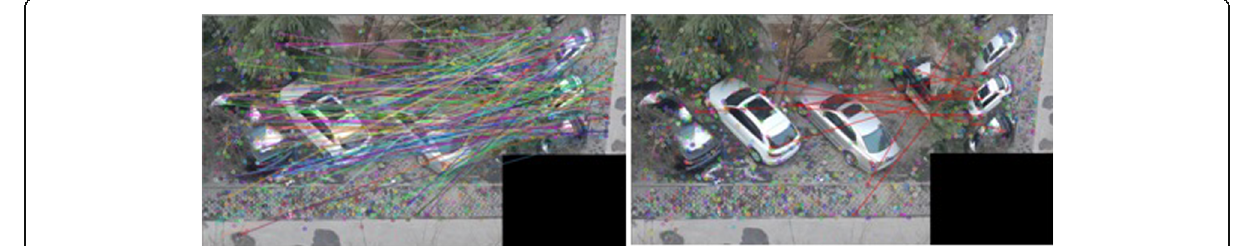
Fig. 18 Results of BRISK algorithm in image detection of different scales